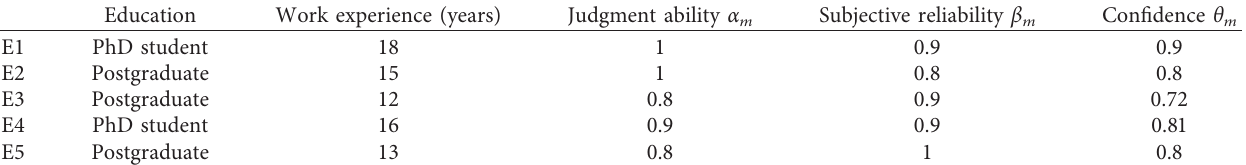
Table 6: Expert confidence.